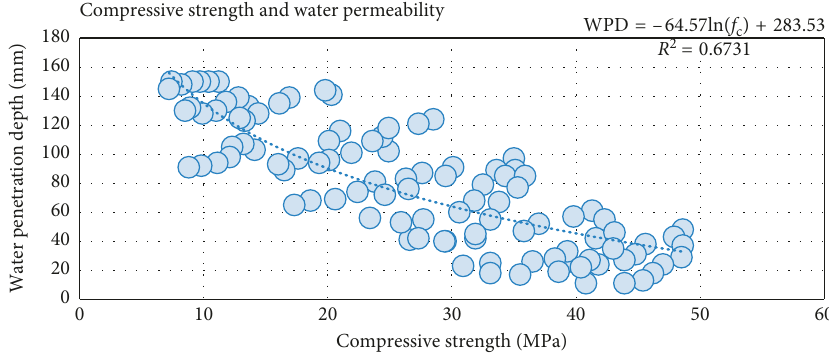
WPD = –64.57ln( f c ) + 283.53 R 2 = 0.6731